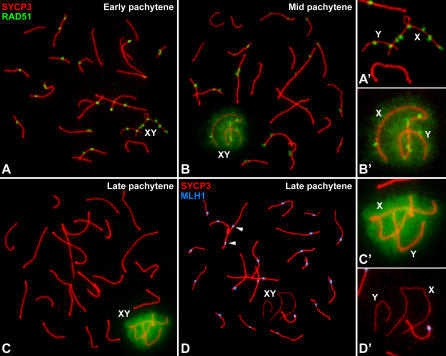
Immunolocalization of SYCP3 (Red) and RAD51 (Green) (A–C) and SYCP3 (Red) and MLH1 (Blue) (D) Proteins on Spread Spermatocytes(A–A′) At early pachytene RAD51 foci are visible over the autosomes. This protein also appears associated to the AEs of sex chromosomes (enlarged in A′).(B–B′) At mid pachytene the number of RAD51 foci over the autosomes and sex chromosomes decreases, but RAD51 begins to accumulate over the sex chromatin as a diffuse signal.(C–C′) At late pachytene RAD51 is absent from autosomes but intensely extended on the sex chromatin.(D) MLH1 protein is detectable at late pachytene as one single dot over most of the autosomal axes, although some bivalents present two (arrowheads). No signal of this protein is detected over the axes of the sex chromosomes (D′).